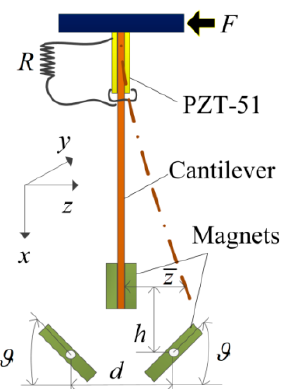
Figure 1. Schematic plot of the asymmetric monostable energy harvester (MEH).